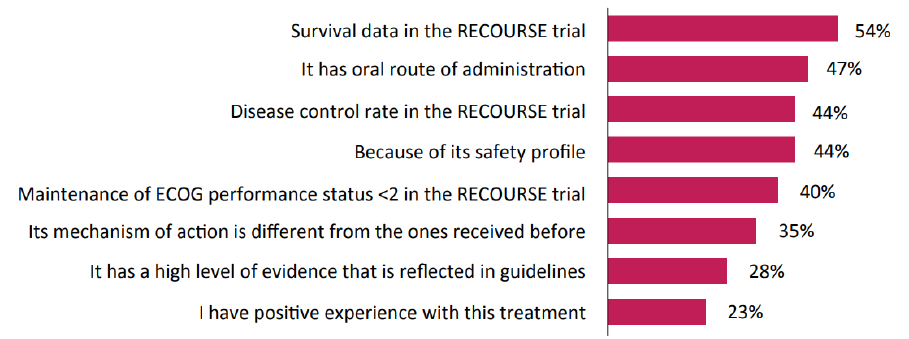
Figure 3. Physicians’ responses on why oxaliplatin rechallenge is an unsuitable third-line treat- ment in a KRAS -mutant patient with comorbidities and previous tolerability issues. ECOG = East- ern Cooperative Oncology